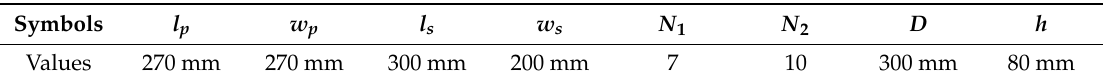
Figure 4. The schematic diagram of multiple transmitting coil and single receiving coil. Table 1. The parameters of coils.